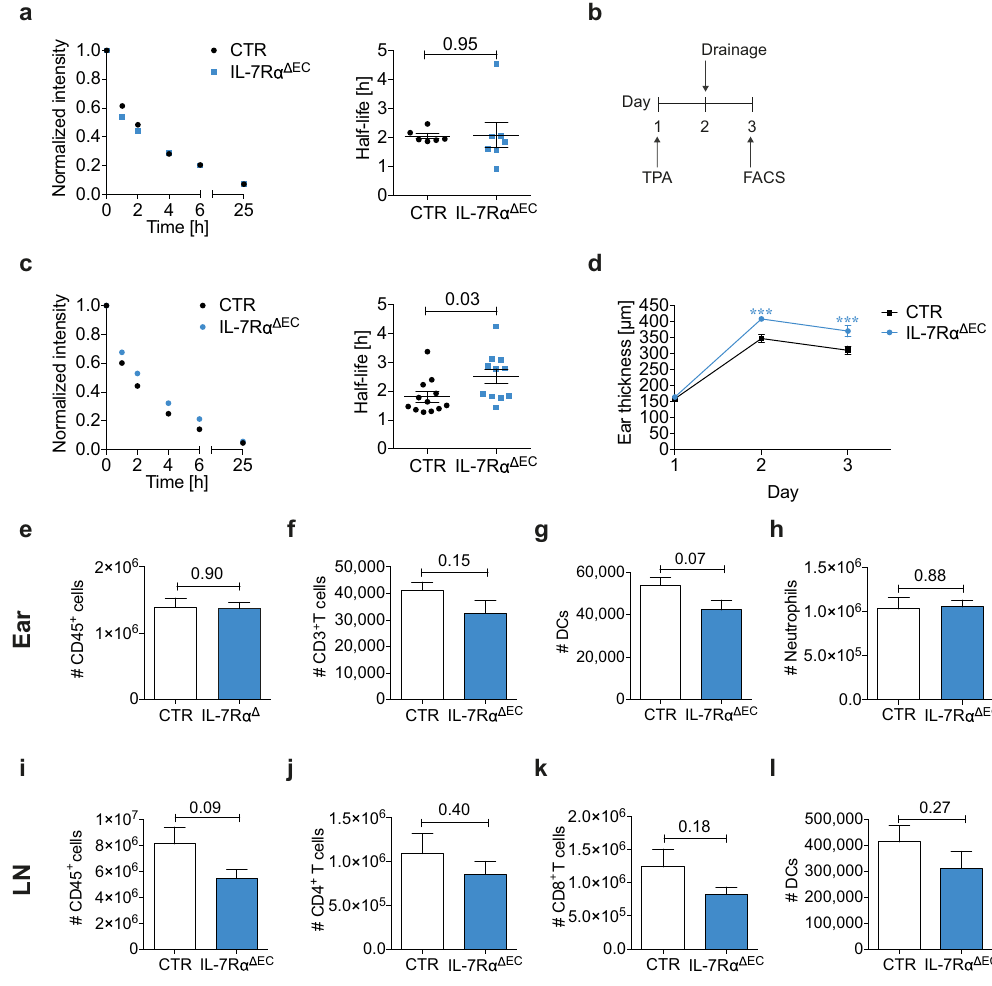
Figure 1. Endothelial-specific deletion of IL-7R α decreases lymphatic drainage and increases edema formation in TPA-induced inflammation. ( a ) IL-7R α Δ EC and control (CTR) mice were injected with a P20D800 conjugate i.d. in the uninflamed ear skin. Clearance of the tracer was monitored over 24 hours using an IVIS imaging system. Average clearance plots of P20D800 (left) and calculated half-lives (right) in CTR and IL-7R α − / − mice (data from 1 experiment with 6 mice per group). ( b ) TPA (black arrow) was applied to the ears of IL-7R α Δ EC and CTR mice on day 1. ( c ) Average clearance plots of P20D800 (left) and calculated half-lives (right) on day 2 after TPA, assessed as in (A). ( d ) Ear thickness measurements between days 1–3. *** p < 0.001. FACS-based quantification of the number of ( e , i ) CD45 + cells, ( f ) CD3 + T cells, ( g – l ) DCs, ( h ) neutrophils, ( j ) CD4 + T cells, ( k ) CD8 + T cells in the ear skin ( e – h ) and dLNs ( i – l ) on day 3. Per animal, both ears and both ear-dLNs were pooled for the FACS analysis. Pooled data (mean ± SEM) from 2 similar experiments with a total of 11–12 mice per group are shown for ( b – l